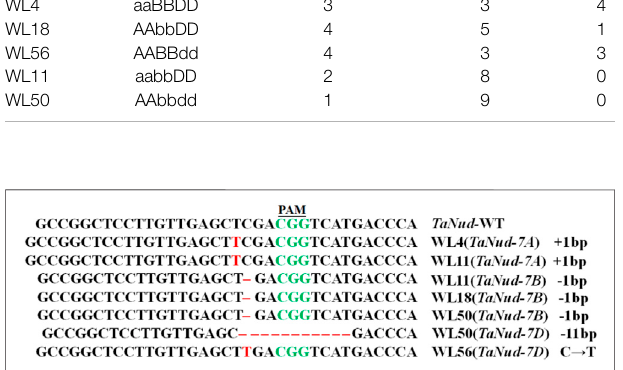
FIGURE 7 | InDel mutations in TaNud genes in the edited T 1 transgenic wheat plants.